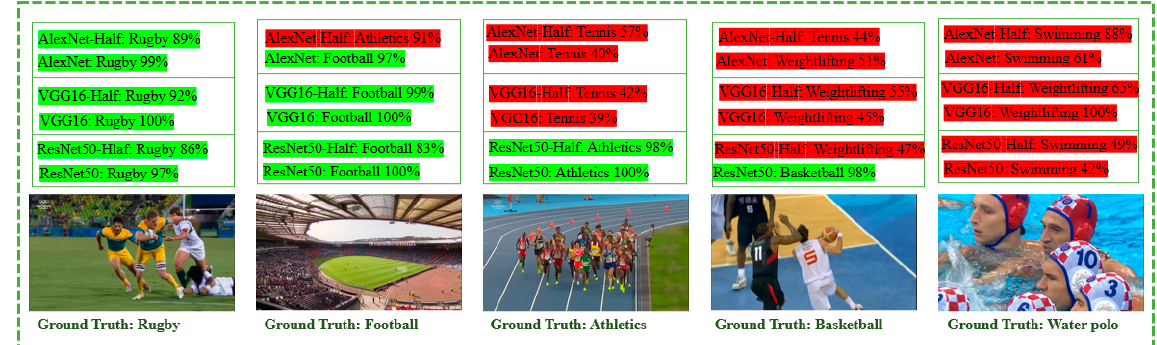
Figure 6. Classification visualization examples of AlexNet [4], VGG-16 [5], and ResNet50 [6] models on OGED test set. The correct and incorrect classification results are marked in green and red, respectively.